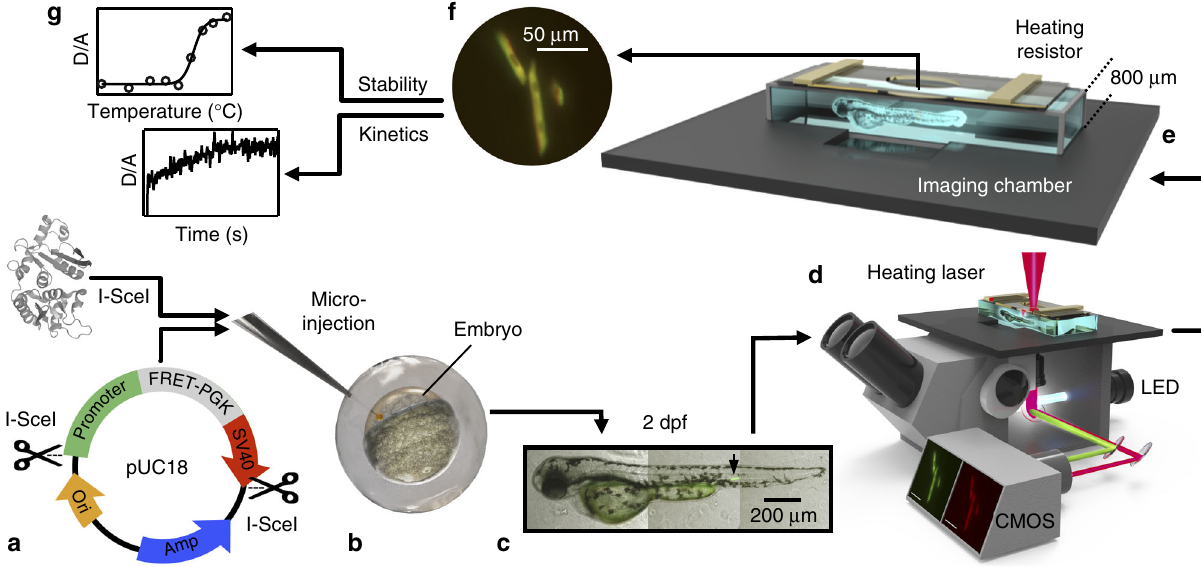
Fig. 1 A customized pipeline to probe the dynamics and stability of endogenously expressed proteins in different tissues of living zebra fi sh. a The pUC18 transgene cassette is comprised of a tissue-speci fi c zebra fi sh promoter, FRET-labeled protein, and SV40 polyadenylation signal fl anked at both ends by I- SceI recognition sites. b I-SceI meganuclease (PDB ID: 1R7M, rendered using VMD 38 ) and the pUC18 transgene cassette are microinjected into